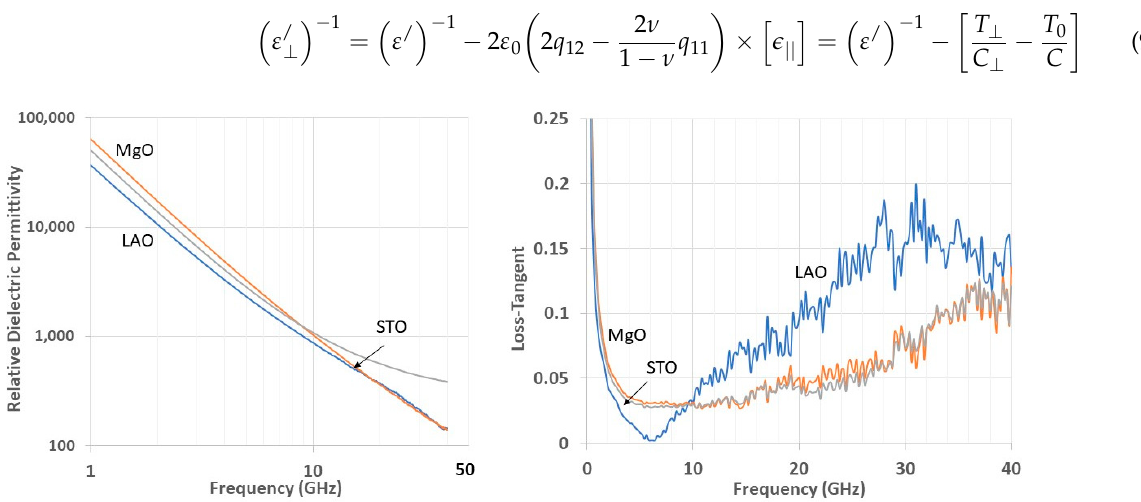
Figure 5. Frequency-dependent, out-of-plane, dielectric properties of BST-0.5 films on crystalline substrates at RT and zero bias.